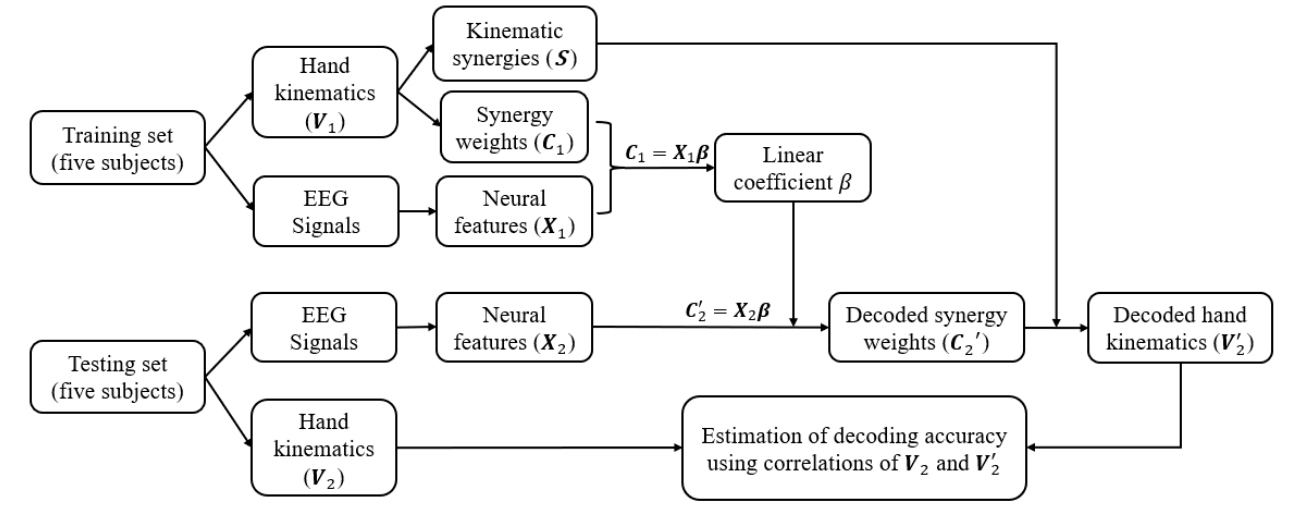
Figure 5. The decoding methodology. Ten subjects were randomly divided into two equal groups for training and testing. The training set of five subjects was used to derive the kinematic synergies and model the linear correlation between the synergy weights and corresponding neural features. In the testing phase, by using the coefficients and extracted kinematic synergies from training set, the synergy weights were decoded from neural features and the hand kinematics were reconstructed for testing set. The performance of the neural decoded and reconstructed kinematics was estimated from the correlations between the recorded kinematics and reconstructed kinematics.